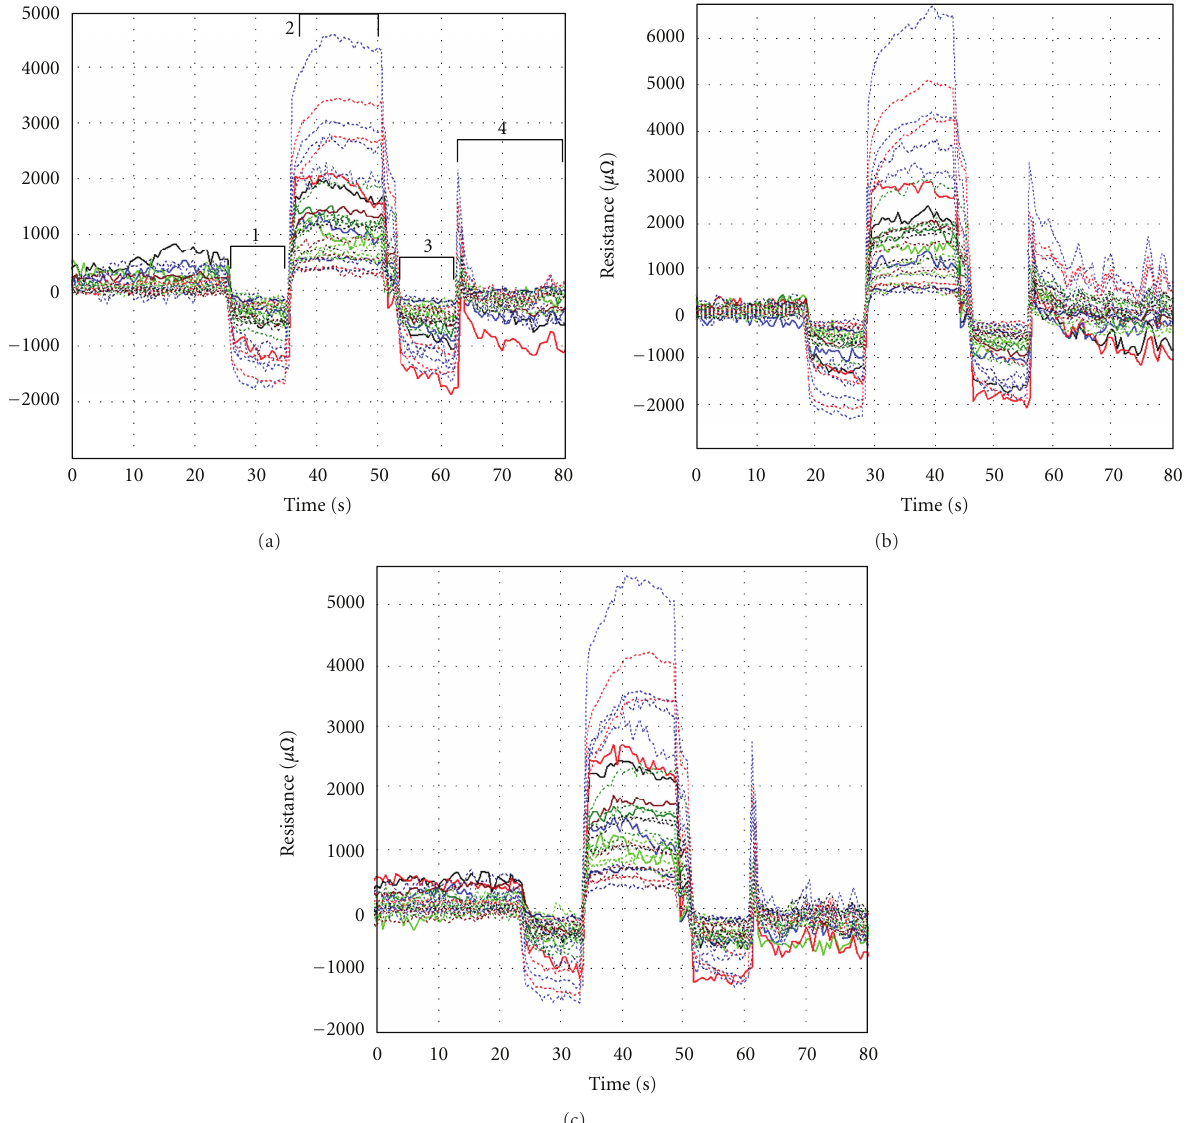
Figure 4: Representative E-nose sensor response patterns (smellprints) based on a 15sec sample of headspace VOC emissions from unexposed (control) cotton bolls (a), or bolls exposed to Euschistus servus (b), and Nezara viridula (c) following 3d of feeding damage. 1: baseline purge; 2: sample draw; 3: air purge; 4: sample